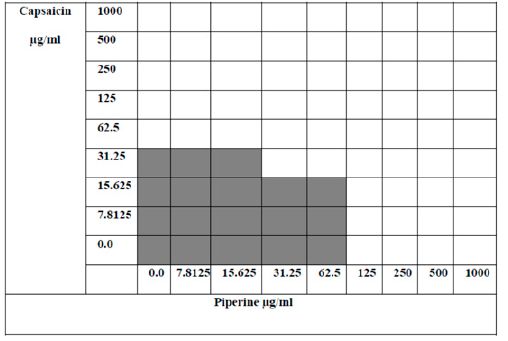
Fig. 5. Checkerboard method showing the prepared diluted concentrations of capsaicin and piperine (bolded squares refers to a positive bacterial